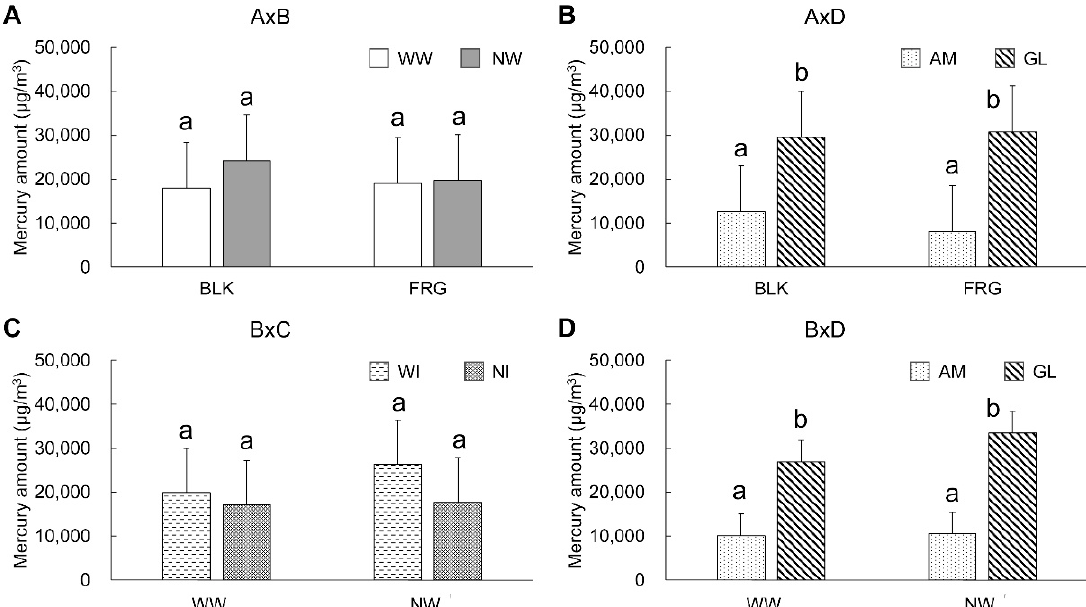
NS indicates no significant difference ( p > 0.05) and ** for significant differences ( p < 0.01) between the conditions in each factor.